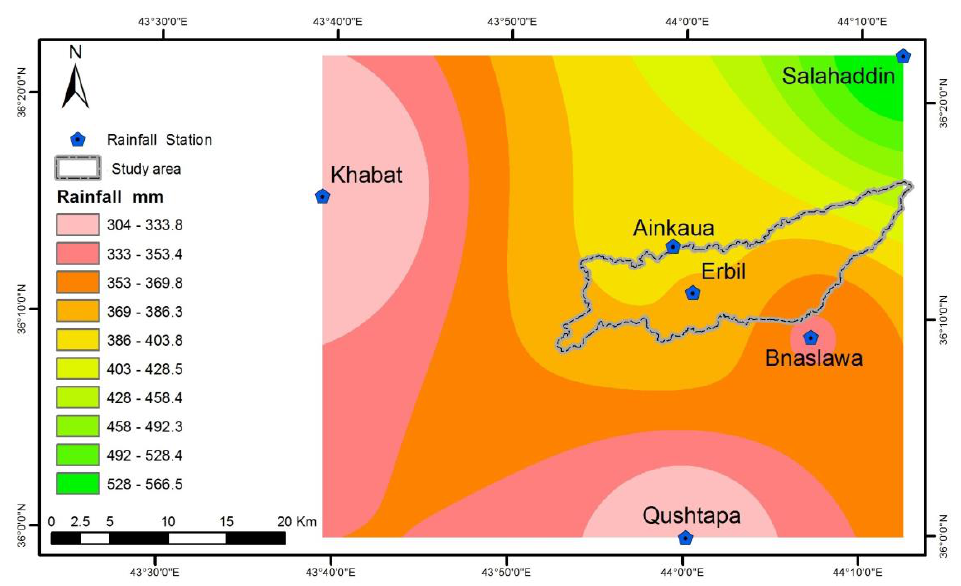
Figure 4. Spatial distribution of rainfall and rainfall station positions in the study area.